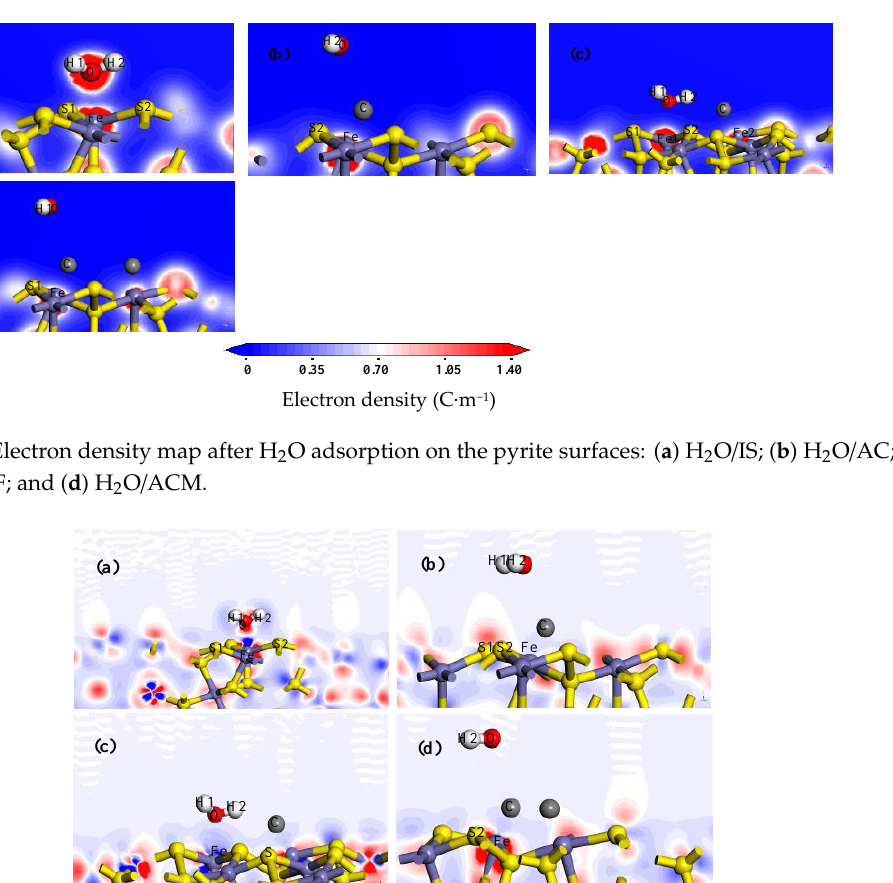
Figure 4. Charge density difference after H 2 O adsorption on the pyrite surfaces: ( a ) H 2 O/IS; ( b ) H 2 O/AC; ( c ) H 2 O/AF; and ( d ) H 2 O/ACM. Table 3. Bond Mulliken population and length after H 2 O adsorption on di ff erent pyrite surfaces. Adsorption